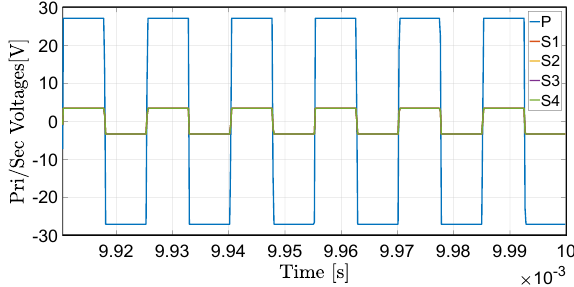
Figure 8. The transformer primary and secondary voltage waveforms in steady state.